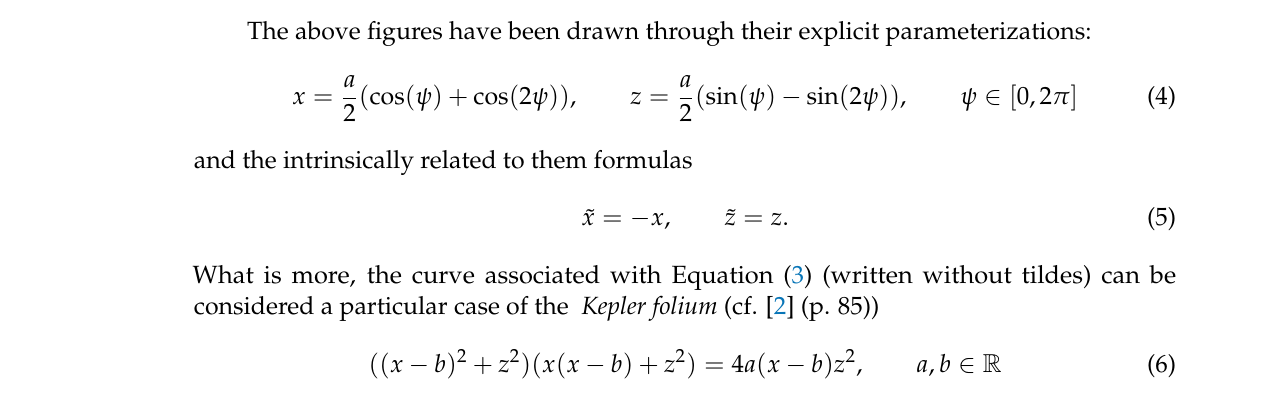
Figure 2. Trifoliums specified by Equations (2) and (3) and the combination of their